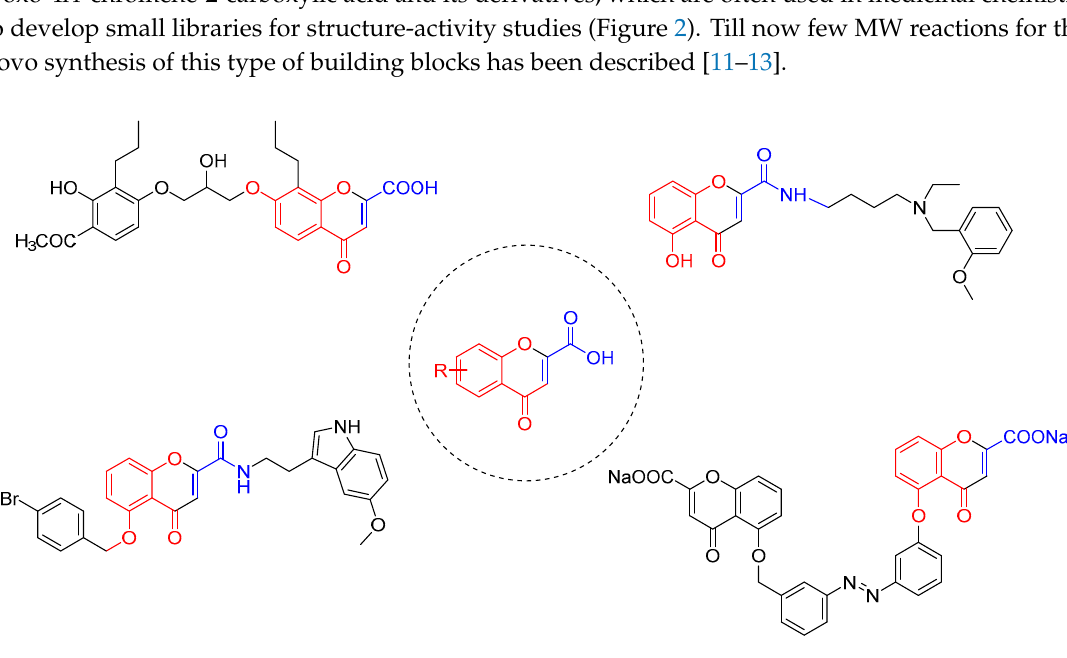
Figure 2. Chromones obtained from 4-oxo-4 H -chromene-2-carboxylic acid with relevant biological activity [1,2].